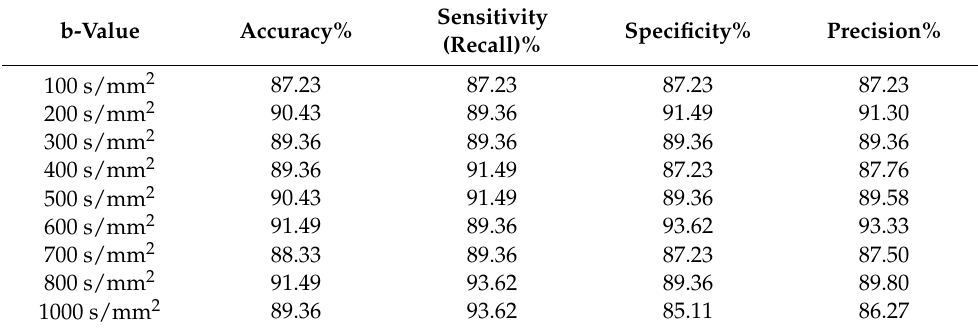
Table 3. Performance of AlexNet at 9 b-values using 94 randomly chosen ADC